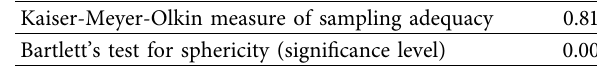
Table 8: KMO and Bartlett tests.